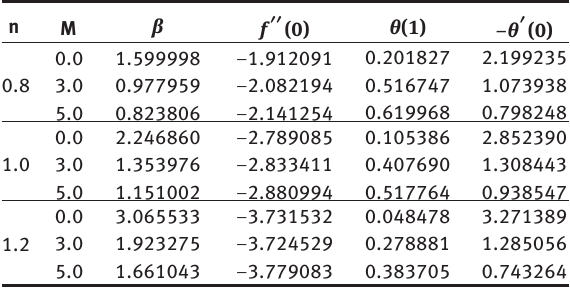
Table 3: Values for β , f (cid:2)(cid:2) (0) , θ (1) and − θ with S = 0.8, M 1 = 1.0, Pr = 1.0, Nr = 0.5, Ec = 0.1, Q = 0.05 and ϵ = 0.1 .